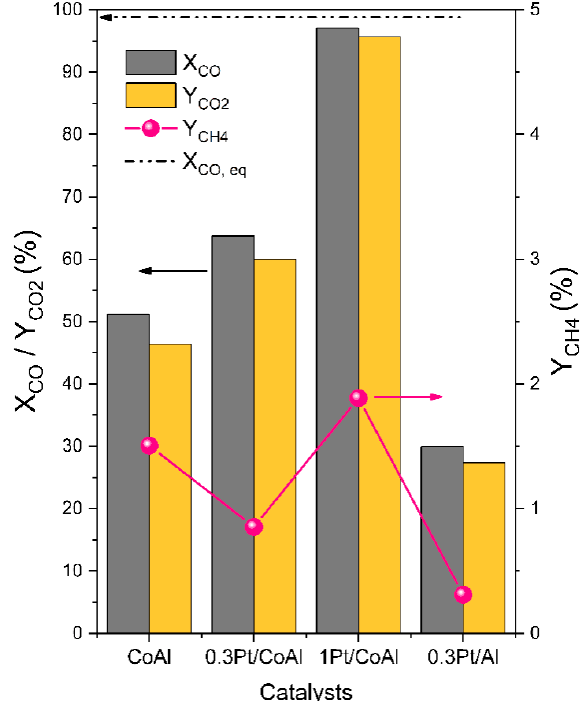
Figure 5. CO conversion and product yields in liquid phase WGS reaction at 260 °C/50 bar and TOS 10 h. Feedstream: H 2 O / CO = 15 / 1 mol ratio, space-time = 76.8 kg cat · s / mol CO . =t 10 h. Feedstream: H 2 O/CO = 15/1 mol ratio, space-time = 76.8 kg cat ·s/mol CO .